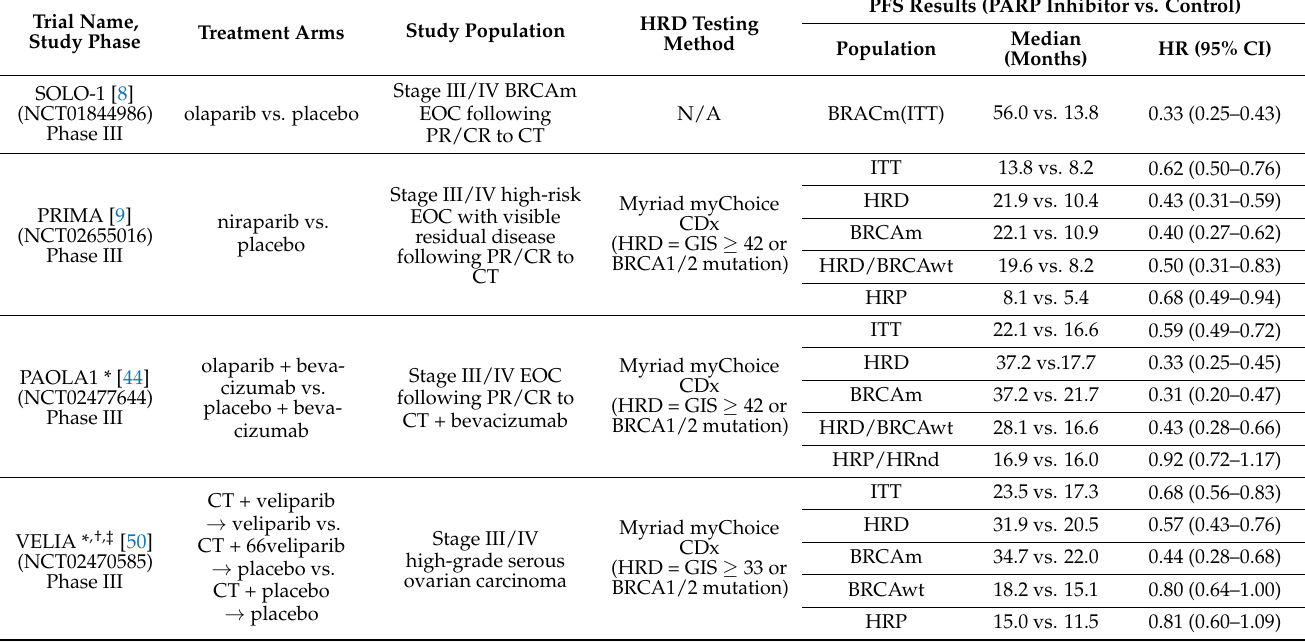
Table 2. Progression-free survival results by molecular subgroups from key studies investigating PARP inhibitors as first-line maintenance therapy in advanced